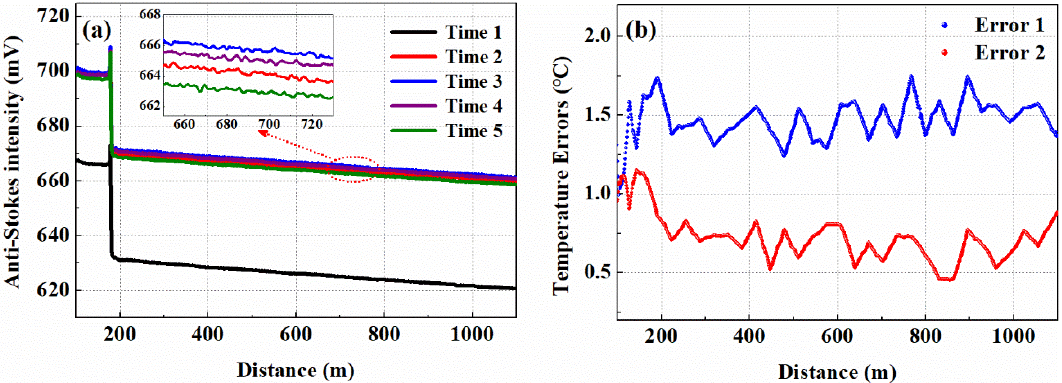
Figure 1. ( a ) The intensity of anti-Stokes backscattered light at di ff erent measuring times; Figure 1. (a) The intensity of anti-Stokes backscattered light at different measuring times; (b) The ( b ) The temperature errors caused by di ff erent measuring temperature errors caused by different measuring times.